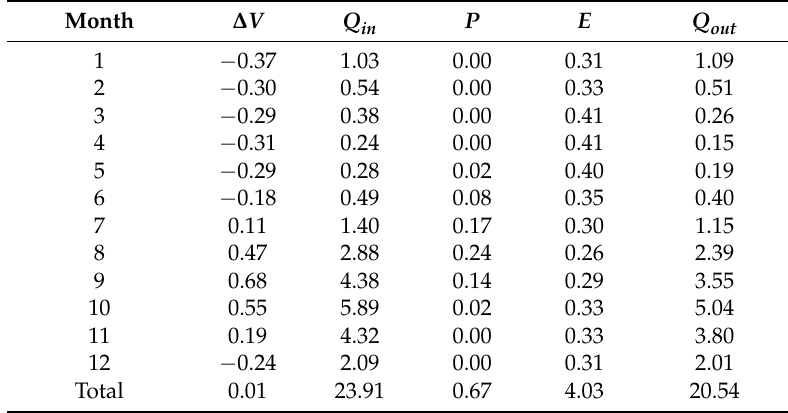
Table 1. Monthly mean values (km 3 ) for the components of the SPLC water budget.